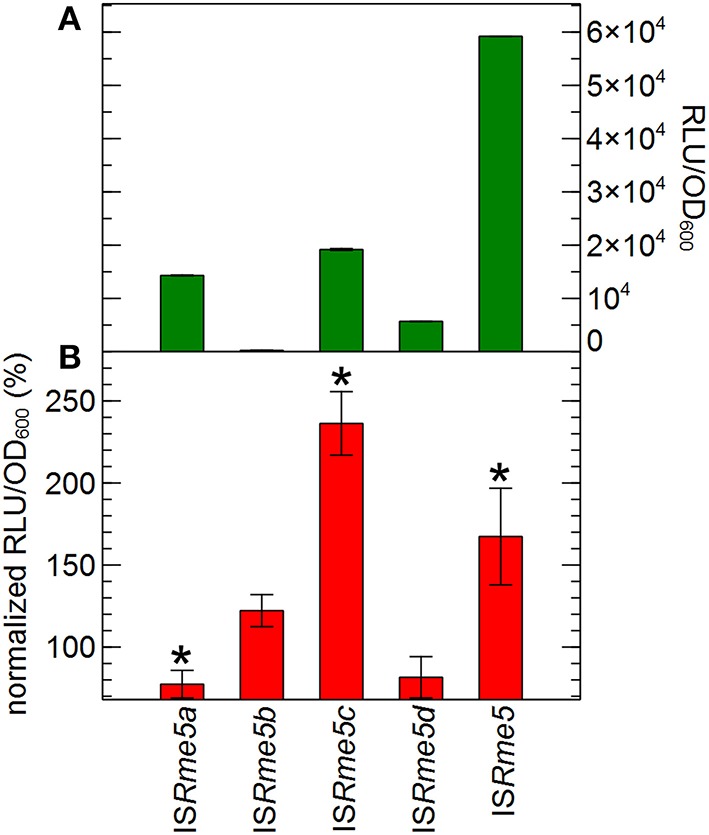
Transposase expression of the different ISRme5 copies. Reporter constructs contain the ISRme5 tranpsosase promoter (starting from the left inverted repeat) and for the four ISRme5 (a, b, c, and d) copies, in addition, the DNA sequence (~250 bp) upstream the integration site. (A) Basal expression of the reporter constructs at the start of the experiment, calculated by normalizing the reporter signal RLU to cell density (RLU/OD600). (B) Expression after 4 h of incubation in the presence of 100 μM Zn2+, calculated by normalizing the reporter signal RLU to cell density (RLU/OD600) to that of the control without added Zn2+. *indicates significant difference between Zn2+ and control, determined by a t-test with a p < 0.05. The average values of three independent experiments with standard deviations are shown.